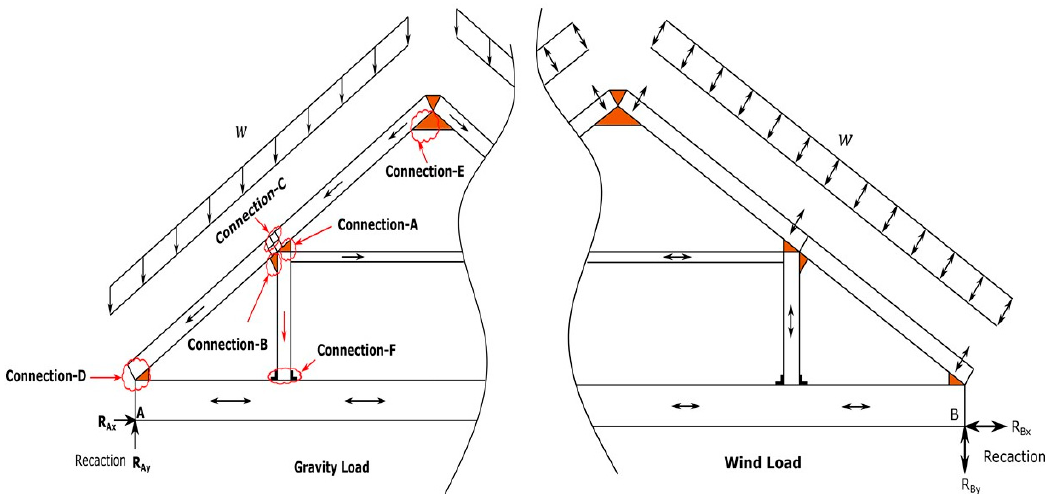
Figure 6. Connection location and load cases.